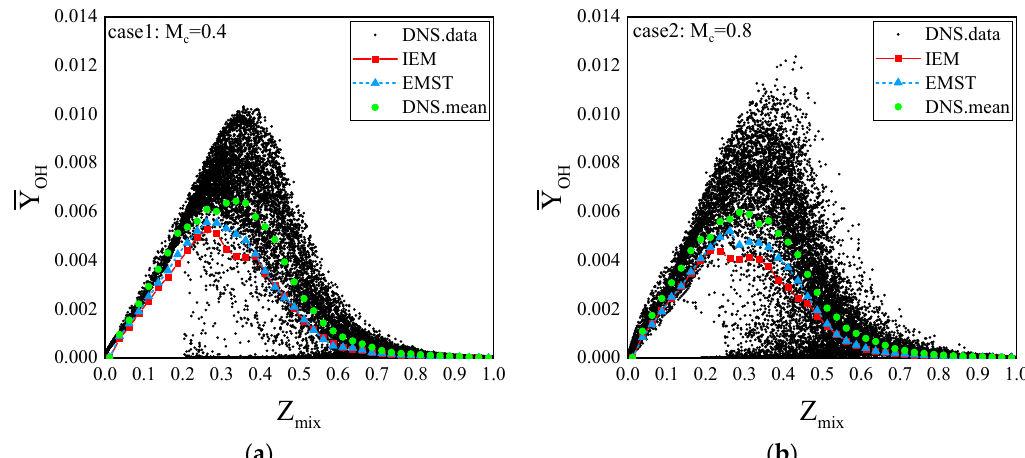
Figure 14. Scatter plots and conditional mean of Y OH obtained using different mixing models for ( a ) M c = 0.4 case and ( b )